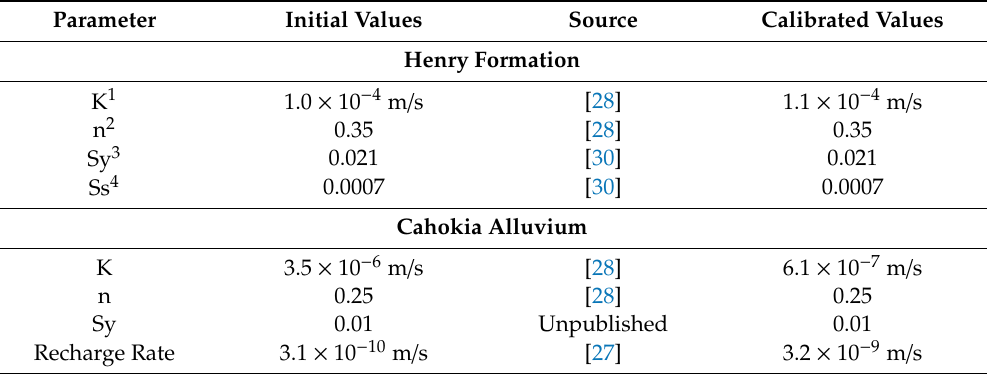
Table 1. Initial and calibrated values employed in the numerical